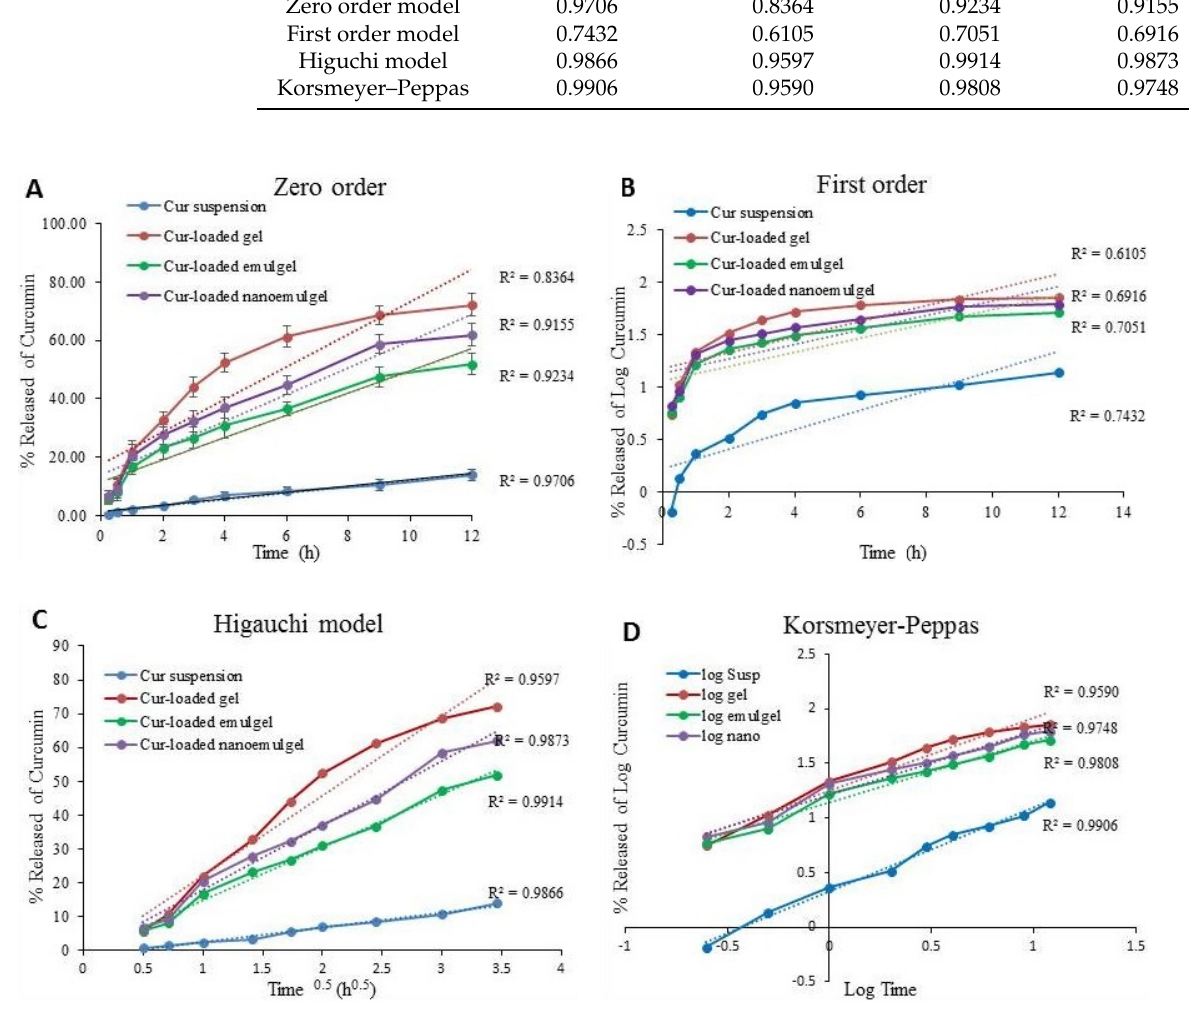
Figure 5. Amount of drug released from Cur-loaded formulations versus curcumin suspension and their kinetics according to ( A ) zero order, ( B ) first order, ( C ) Higuchi model and ( D ) Korsmeyer–Peppas model.